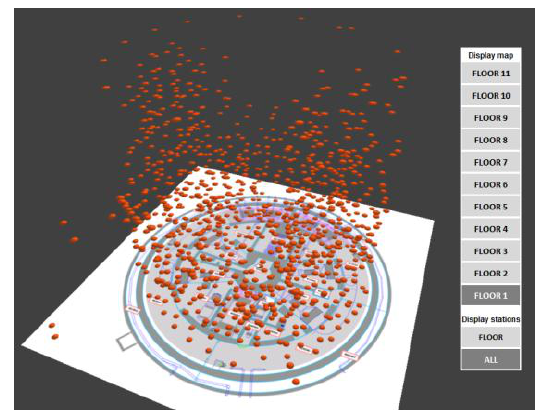
Figure 3 Visualization of the 1000+ stations (co-stationning TLS and RGB) performed during the acquisition campaign of as-built data of an industrial plant.